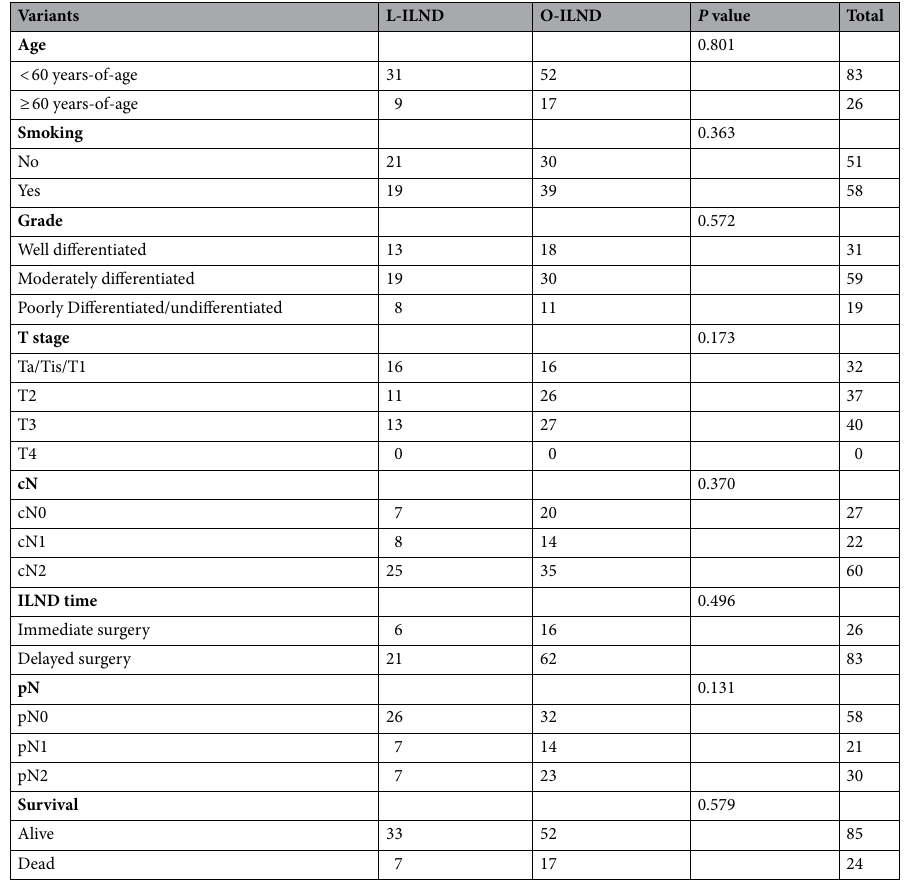
Table 1. Clinicopathological data relating to 109 patients with penile cancer. L‑ILND laparoscopic inguinal lymph node dissection, O‑ILND open inguinal lymph node dissection. P values refer to differences in the indicated parameters when compared between the O-ILND and L-ILND